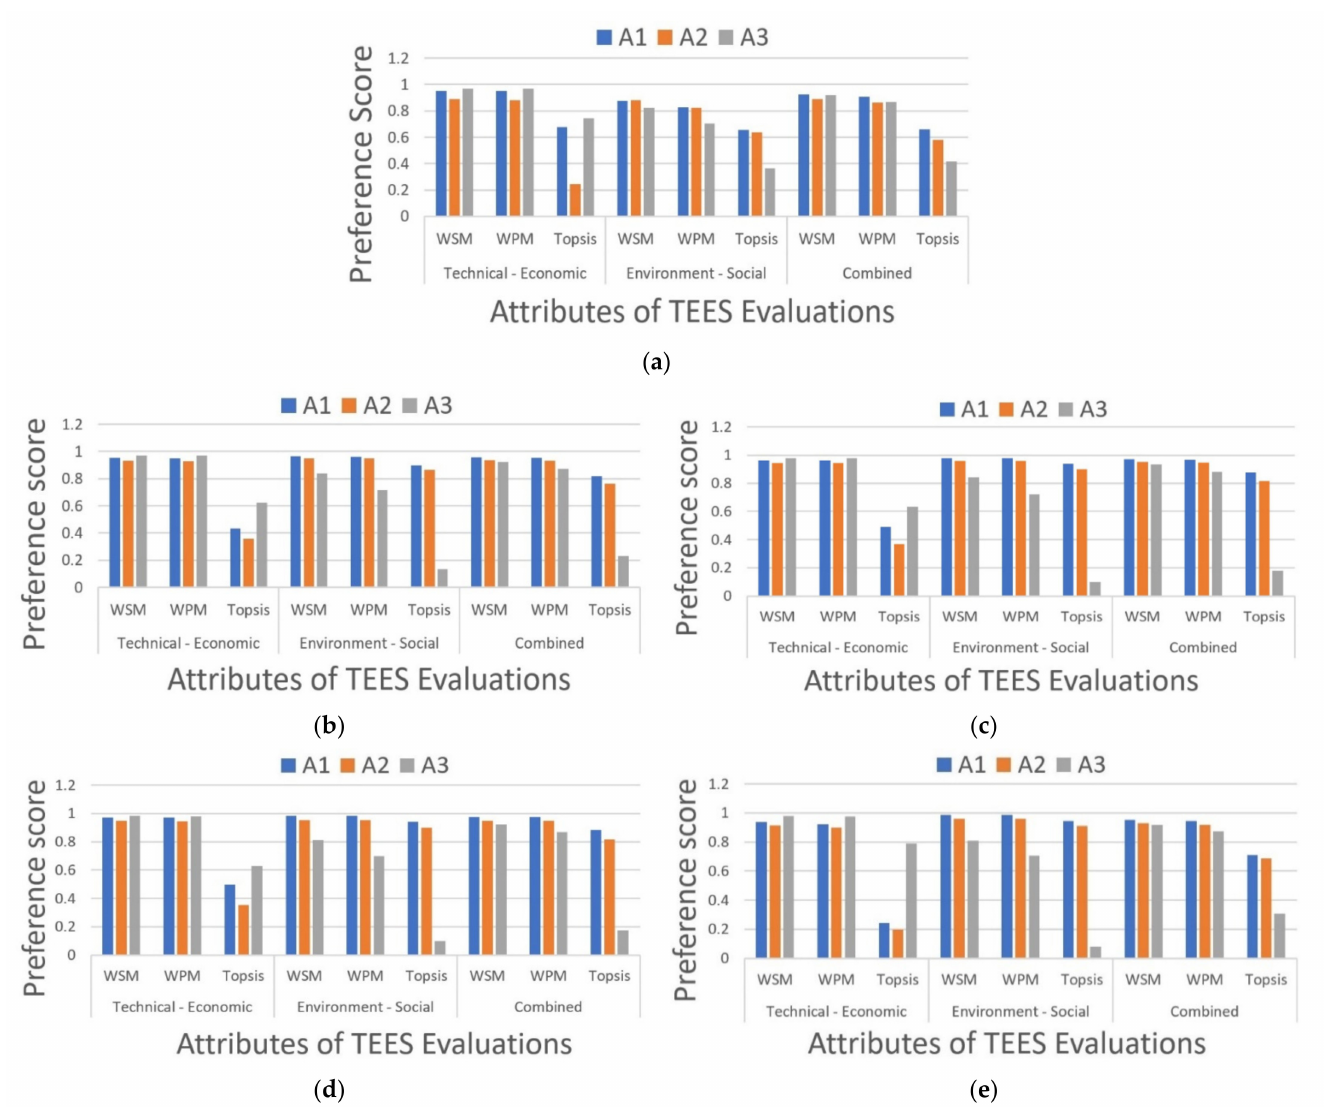
Figure 20. MCDM evaluations for Case 3 considering DG only: ( a ) C3/S1 (NL); ( b ) C3/S2 (LG1); ( c ) C3/S3 (OLG1); ( d ) C3/S4 (LG2); ( e ) C3/S5 (OLG2). Table 16. MCDM evaluations analysis in Case 3 (C3/S1–S5) in terms of UDS for the 65-bus MCMG. C